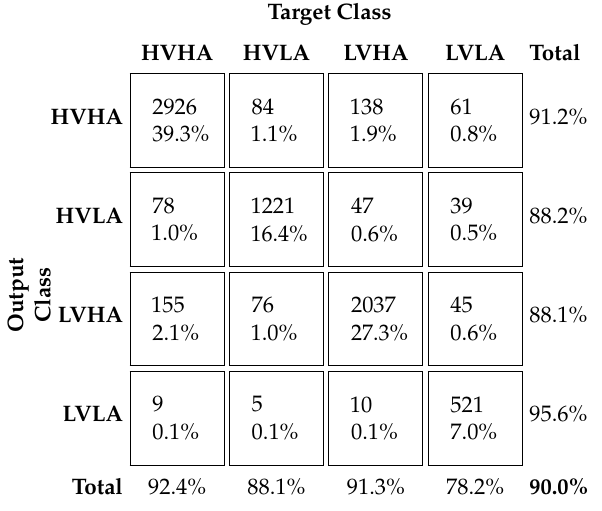
Table 8. Confusion matrix of ECG channel 2 of DREAMER